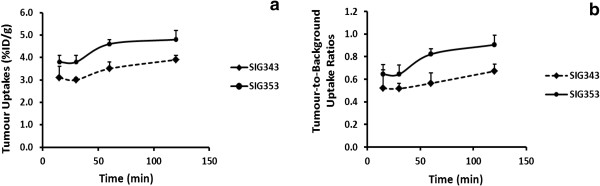
Comparisons of the uptakes in tumour (a) and tumour-to-background uptake ratios (b) of 18F-SIG343 and 18F-SIG353. Results were presented as %ID/g in the tumour and the uptake in the tumour compared to the residual activity remained in the body (tumour-to-background uptake ratios) at 15, 30, 60 and 120 min. Data are derived from the biodistribution studies in A373 tumour-bearing mice (means ± SEM, n = 5). *P < 0.05, **P < 0.01, ***P < 0.001 treatment versus control (unpaired, two-tailed Student's t test).